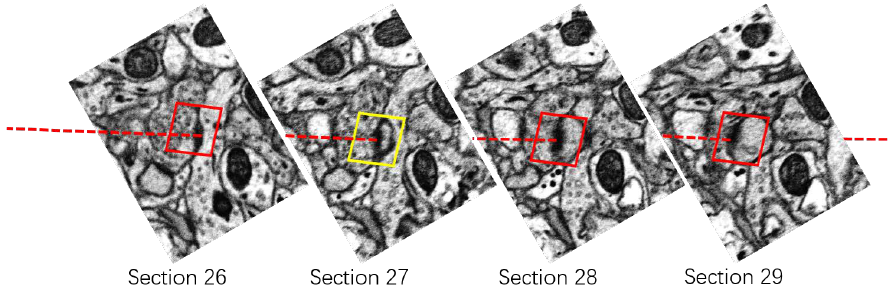
Figure 6. Detection results of synapses on several serial images. The yellow rectangle indicates missed, while the red rectangles indicate correct